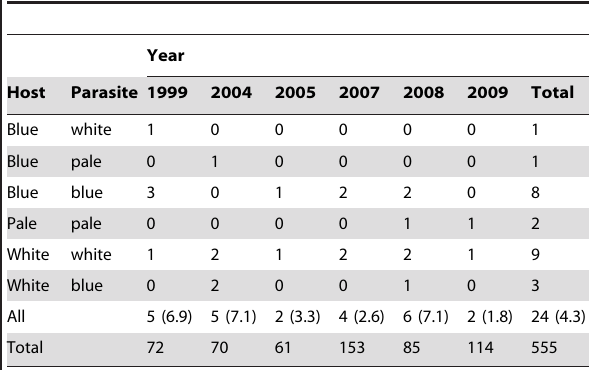
Table 4. Number of ashy-throated parrotbill nests parasitized by common cuckoos.